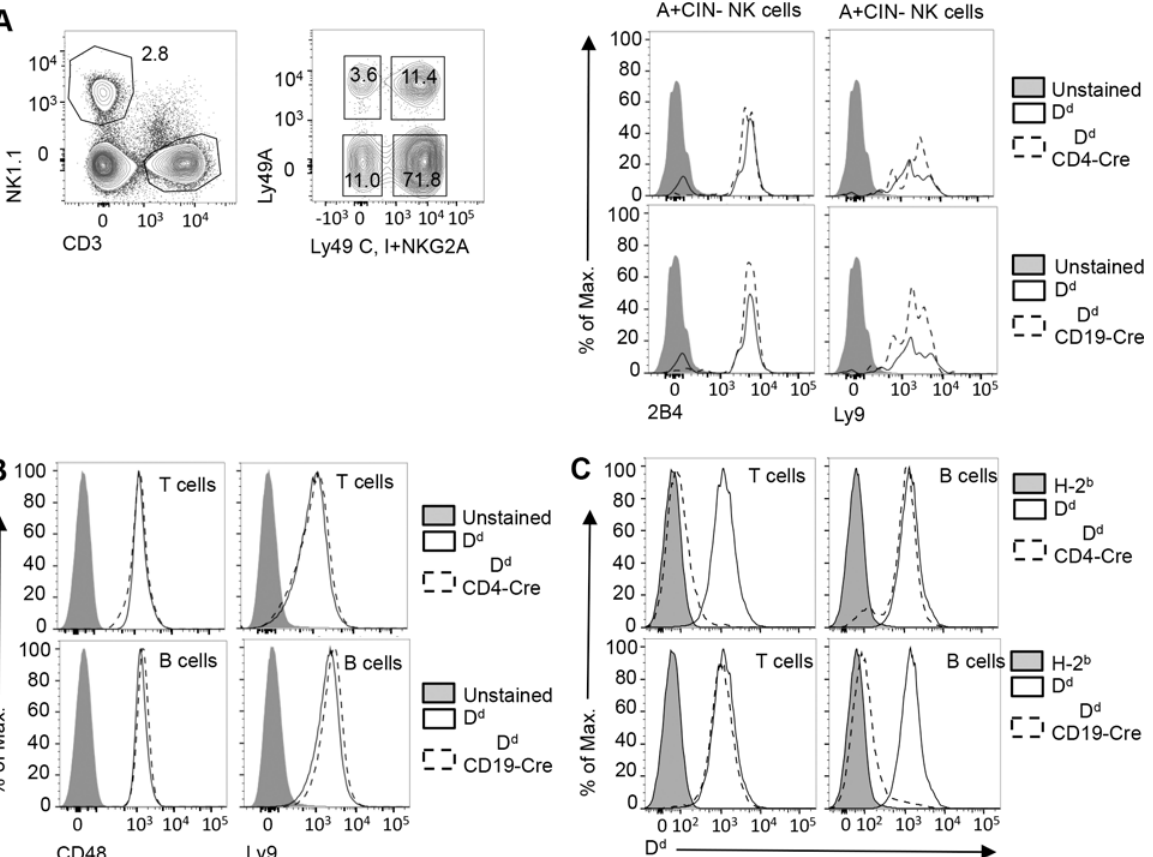
Fig 3. SLAM expression by NK cells is unaltered in D d mosaic mice. (A) NK cells expressing Ly49A and lacking Ly49C, Ly49I and NKG2A (A+CIN-) from primed D d , D d CD4-Cre (T cell specific D d deletion) and D d CD19-Cre mice (B cell specific D d deletion) were analyzed for the expression of 2B4 and Ly9. (B) Histograms depict the expression of CD48 and Ly9 by T cells and B cells from primed D d , D d CD4-Cre (T cell specific D d deletion) and D d CD19-Cre mice (B cell specific D d deletion) mice. (C) Histograms show D d expression by T cells and B cells from primed H-2 b , D d , D d CD4-Cre and D d CD19-Cre mice,